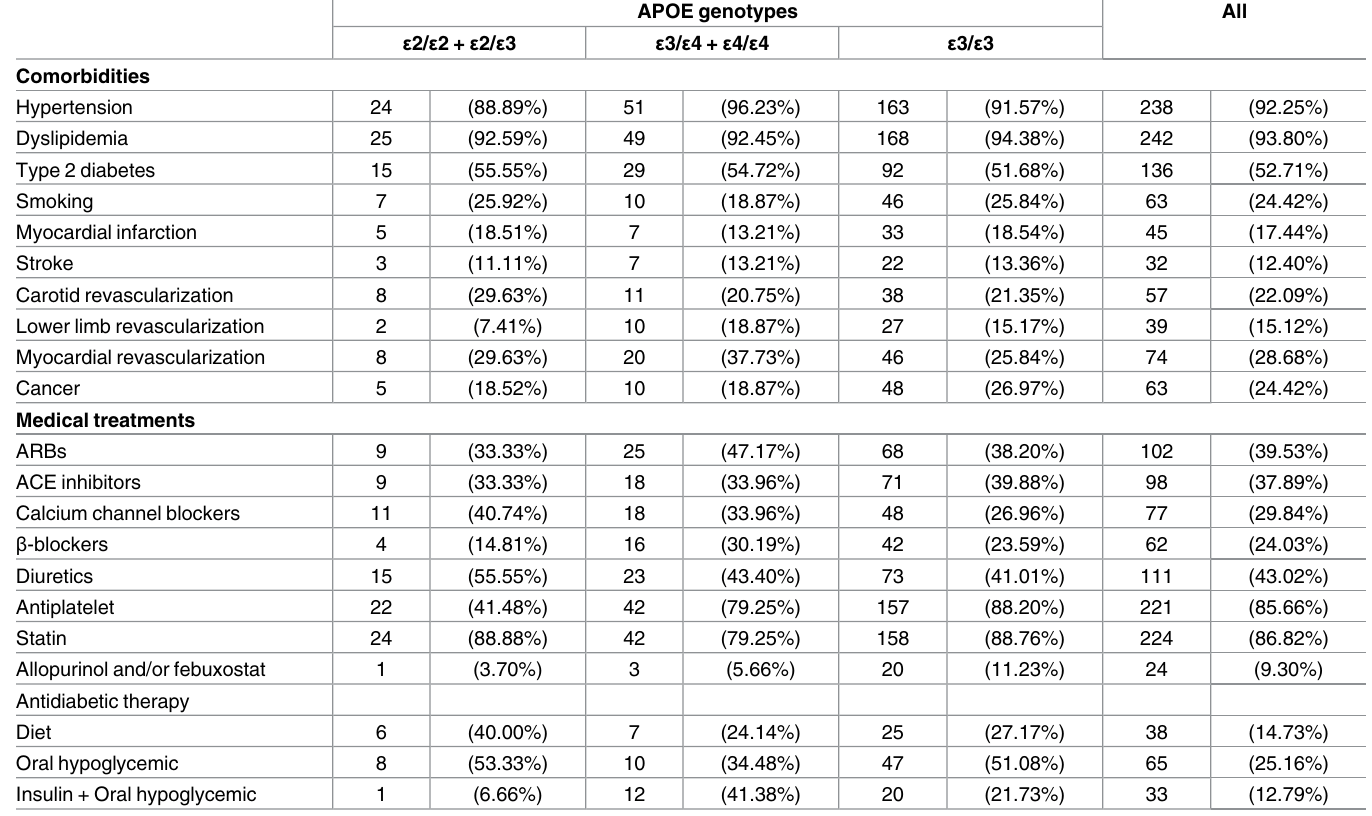
Table 2. Comorbidities and medical treatmentsat baseline according to APOE